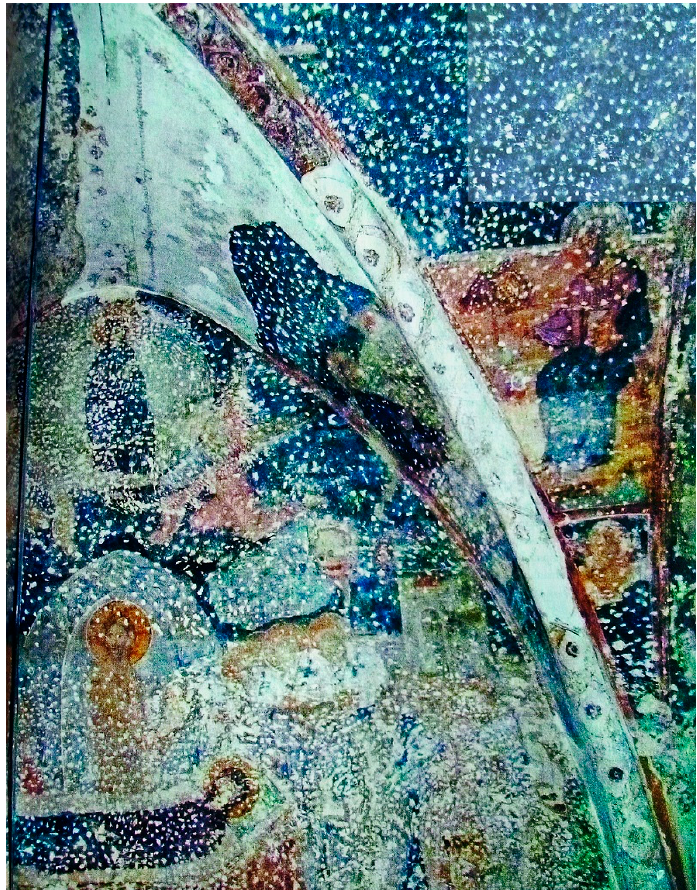
Figure 9. Pera, the church of St. Paul, south wall of the choir, scene of the Dormition of the Virgin Mary and St. Mark (mid-14th century?); after Rönesans (2012, pp.